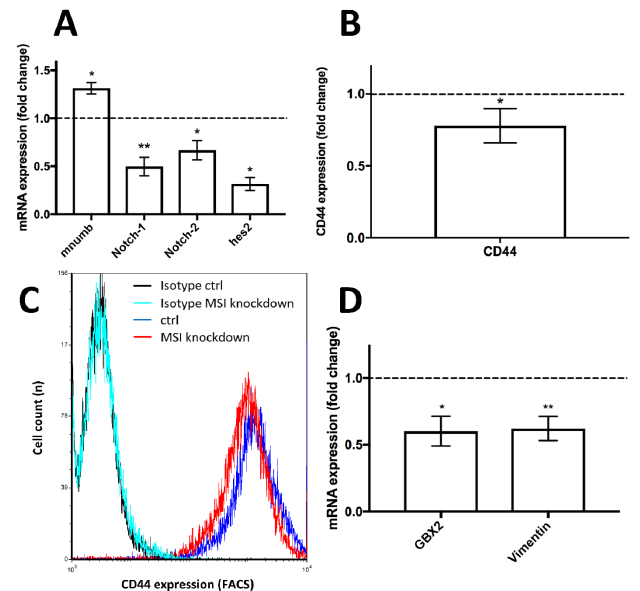
Figure 2. Influence of Musashi ( MSI ) RNA-binding protein knockdown on the Notch pathway and additional stem cell markers in triple-negative MDA-MB-231 cells. A : Upregulation of the Notch pathway repressor mammalian numb ( mnumb ) and downregulation of Notch pathway elements subsequent to MSI-1 and -2 knockdown compared to controls, as measured by quantitative polymerase chain reaction (qPCR). B : Downregulation of stem cell marker CD44 after MSI knockdown compared to controls, as determined by flow cytometry. Representative measurement shown in C (on a logarithmic x scale),